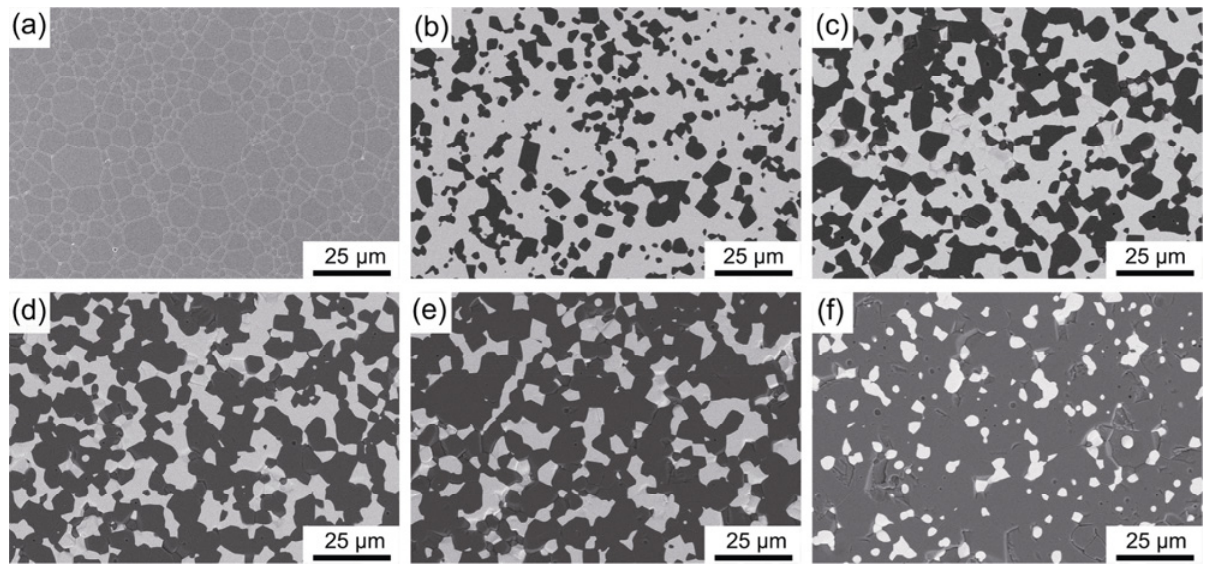
Fig. 2 FESEM micrographs of LACCs with Al 2 O 3 contents of (a) 0 wt%, (b) 20 wt%, (c) 40 wt%, (d) 50 wt%, (e) 60 wt%, and (f) 70 wt%.